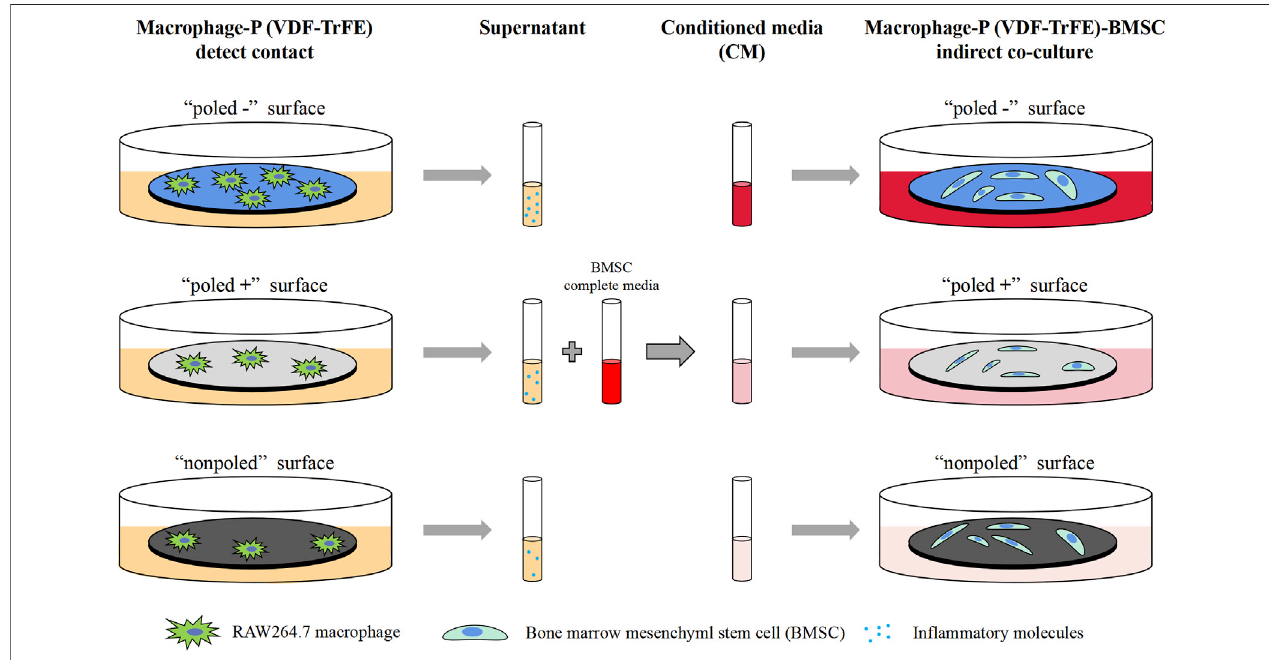
FIGURE 1 | Schematic illustration of the conditioned-media preparation. The supernatants were collected from macrophage-P (VDF-TrFE) culture and the conditioned media were further prepared to cultivate BMSCs.